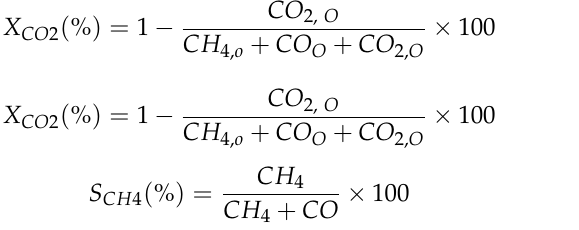
Figure 16. Schematic representation of the plug-flow system used for CO 2 methanation. Experiments were conducted with a reactant gas flow rate of 250 mL/min, a reaction temperature of 350 °C, a GHSV of 30,000/h, and an H 2 /CO 2 ratio of 4. Other parameters were varied as indicated in Table 5. The reaction temperature was varied between 200 °C and 450 °C and the GHSV between 10,000 and 50,000/h at different H 2 /CO 2 ratios to evaluate their effects on CO 2 and H 2 conversion. The H 2 /CO 2 ratio was adjusted with the balance gas N 2 . The effect of the initial CH 4 concentration (0%~16.8%) of biogas was in- vestigated by CO 2 and H 2 conversion and CH 4 production. Table 5. Experimental conditions used for the methanation reaction.